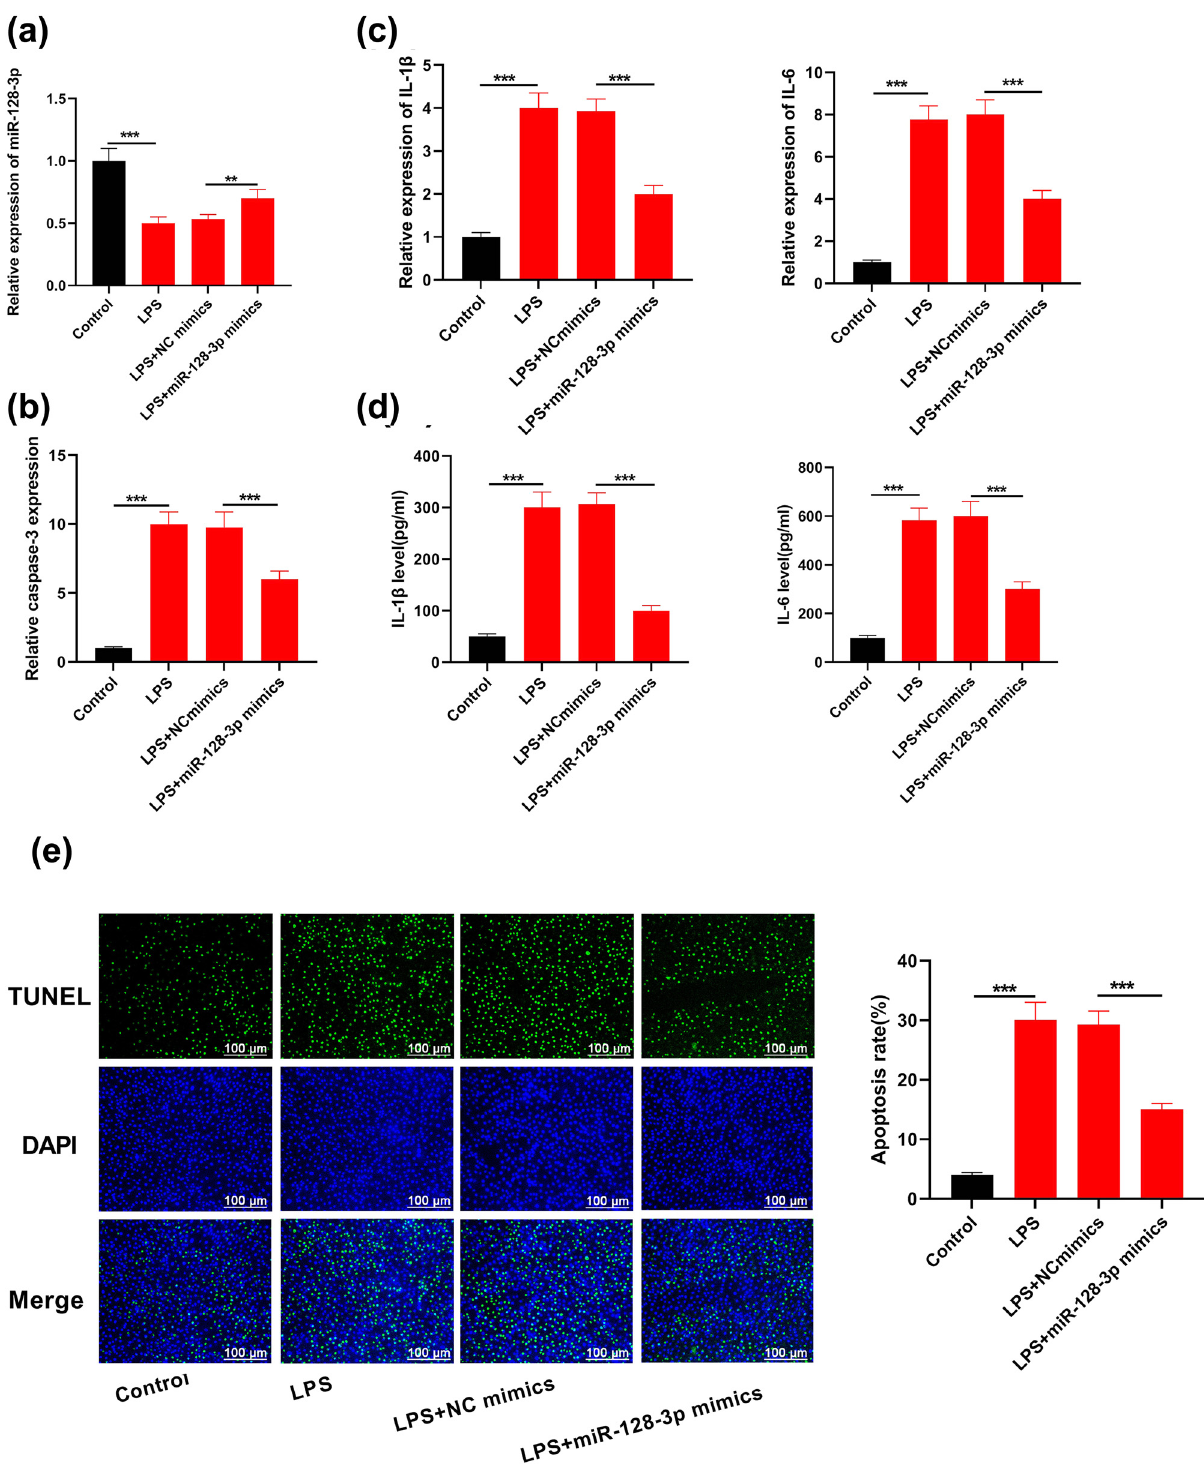
Figure 3: miR - 128 - 3p in fl uence on cellular apoptosis in MPVECs stimulated by LPS and in fl ammatory factors. ( a ) miR - 128 - 3p level was tested in cells that were transfected with mimics of miR - 128 - 3p using RT - qPCR. ( b ) Transcriptive activity of caspase - 3 in cells transfected with miR - 128 - 3p mimics was determined by caspase - 3 assay. ( c ) IL - 6 and IL - 1 β mRNA levels were measured through qRT - PCR. ( d ) TUNEL was utilized to determine apoptosis level in cells that were transfected using mimics of miR - 128 - 3p. ( e ) TUNNEL assay evaluated cell apoptosis. *** P < 0.001, ** P <